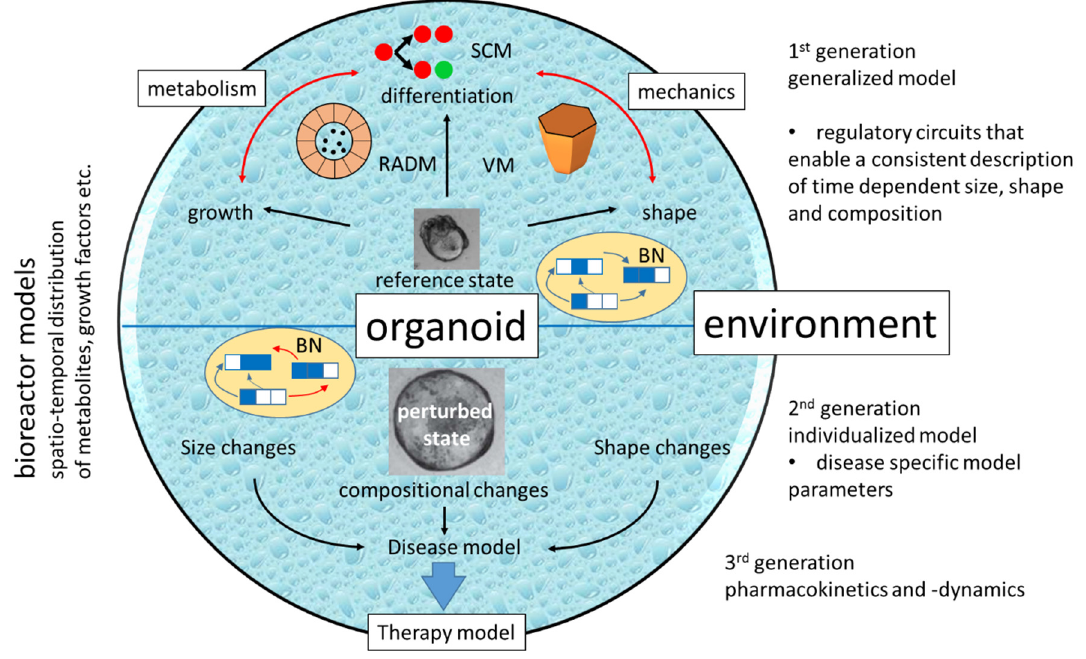
Figure 5. In silico organoids. Currently available are 1st generation COMs for different tissue. However, they often focus on a single aspect such as organoid differentiation, shape formation and limited growth. Accordingly, they use different approaches such as individual cell-based SC models (SCM), vertex models (VM) or reaction-advection-diffusion model (RADM). Missing are COMs combining these aspects in a core regulatory circuit, e.g., a Boolean network (BN), with a limited number of regulatory states. In 2nd generation COMs, individual model parameters and/or regulatory links are changed to simulate a disease model. Its behavior under therapy can then be tested combining it with a ‘bioreactor model’ describing the organoid’s environment.